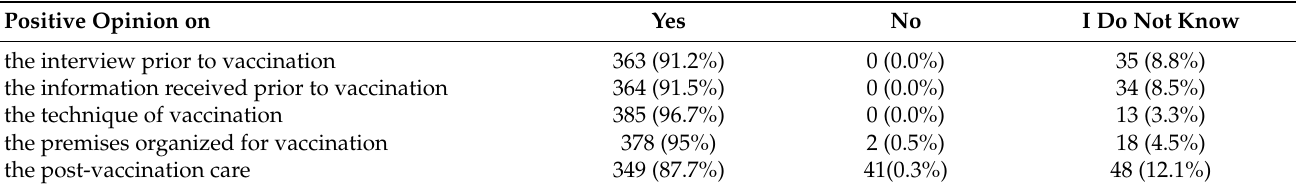
Table 3. Opinions regarding experiences of immunization against COVID-19 at the